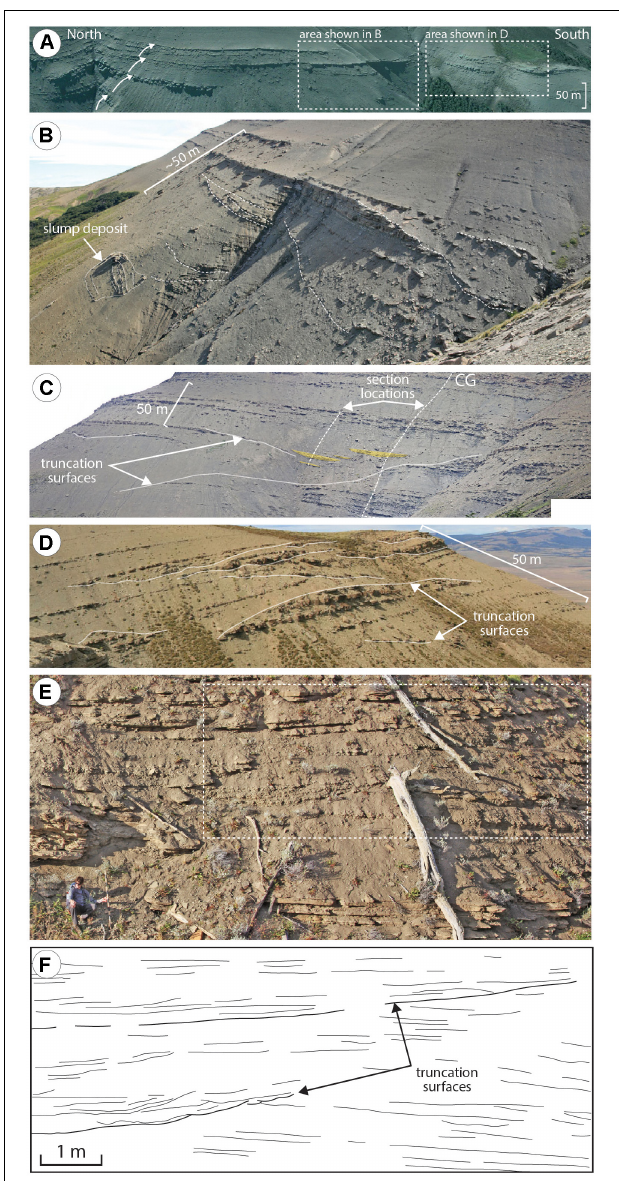
FIGURE 13 | Puma basal clinothem package stratigraphic architecture and facies. (A) Dip-oriented satellite image of Cerro Cazador near the interpreted Puma clinoform shelf margin (refer to Figure 2E for location). White arrows highlight coarsening upward packages (image data: Google, Landsat, Copernicus, 2016, http://google.com/earth/index.html). (B) Incision surfaces (dashed white lines) cutting deltaic strata at the shelf margin. Location shown in (A) . (C) Strike perspective of a significant incision surface (lowest example), which truncates interbedded mudstone and sandstone, and is infilled with comparable facies as well as channelized sandstone (yellow). Paleoflow is approximately out of the page; sub-vertical white lines indicate the location of measured sections ( Figure 2E for location). (D) Multiple erosion surfaces (white lines) that truncate deltaic deposits in proximity to the shelf edge rollover. Location shown in (A) . (E) Photograph and (F) line drawing trace of fine-grained sandstone and mudstone at a distal location of the Puma basal clinothem package. Truncation surfaces are apparent, and erosional relief is in-filled with facies similar to that which was incised. Outcrop location denoted on Figures 2C,E , 3 .